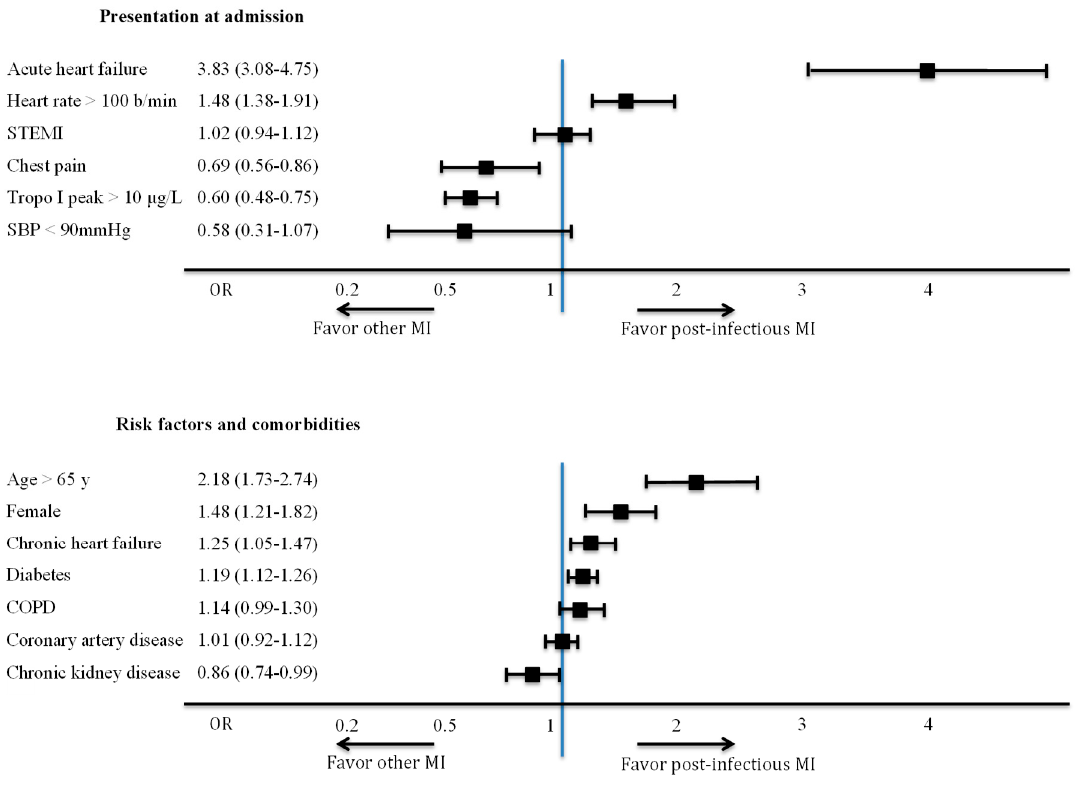
Figure 4. Multivariate analysis of factors associated with post-infectious myocardial infarction (Odds ratio (95% confidence interval)). COPD: chronic obstructive pulmonary disease; MI: myocardial infarction; SBP: systolic blood pressure; STEMI: ST segment elevation myocardial infarction; Tropo I peak: cardiac troponin I peak